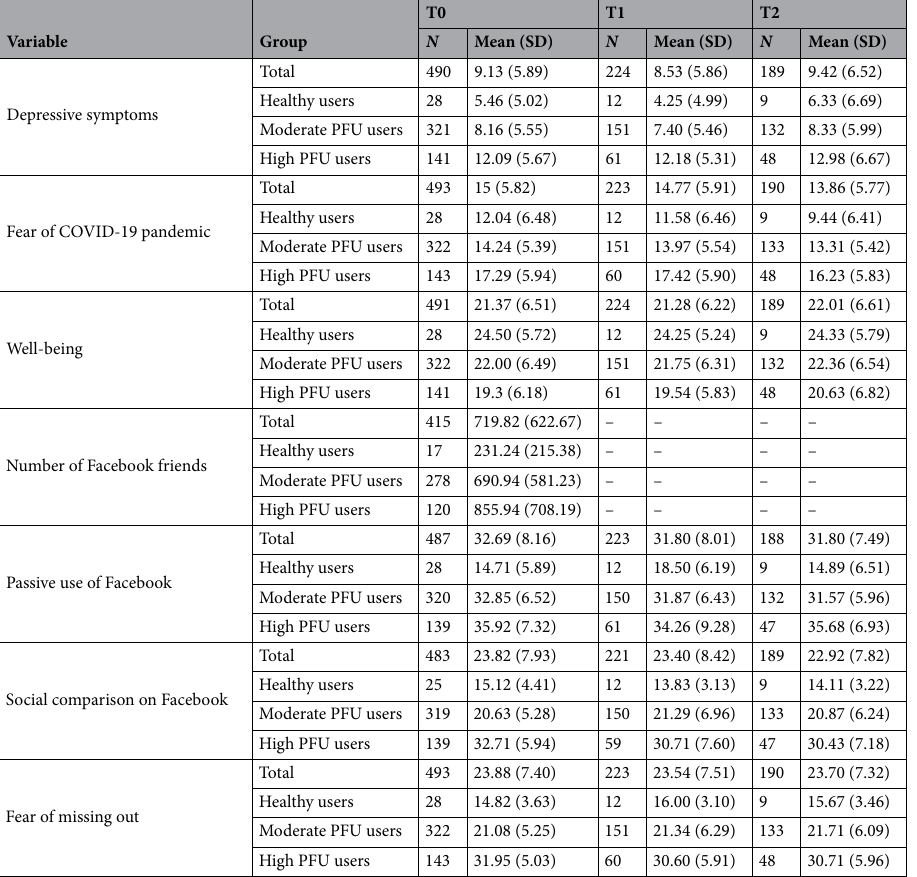
Table 3. Means, standard deviations and total N for all variables, across all time points, for the entire sample and separately for each class. PFU problematic Facebook use, T0 October, 2020, T1 December, 2020; T2 February, 2021.